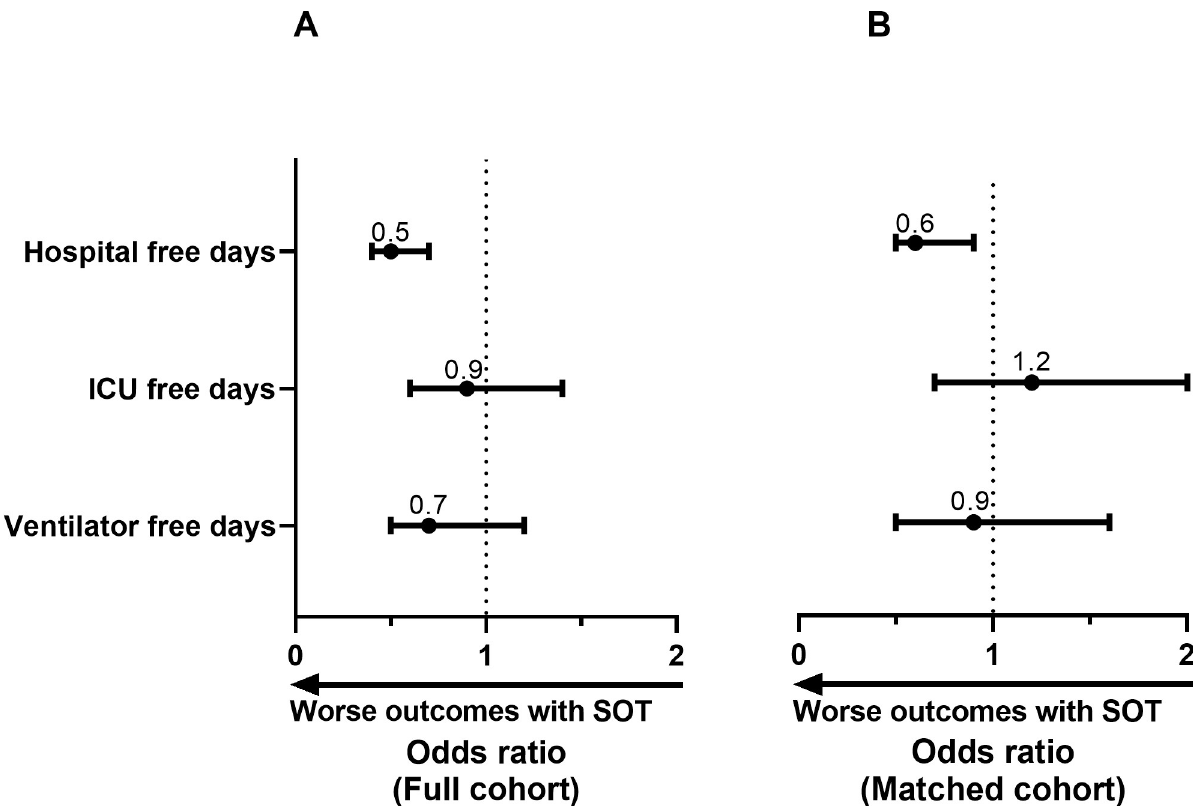
Fig 1. Odds ratio for hospital free days, ICU free days, and ventilator free days. ICU, intensive care unit; SOT, solid organ transplant; An odds ratio < 1 indicates worse clinical outcomes for SOT recipients compared to controls. Odds ratios were calculated using proportional ordinal